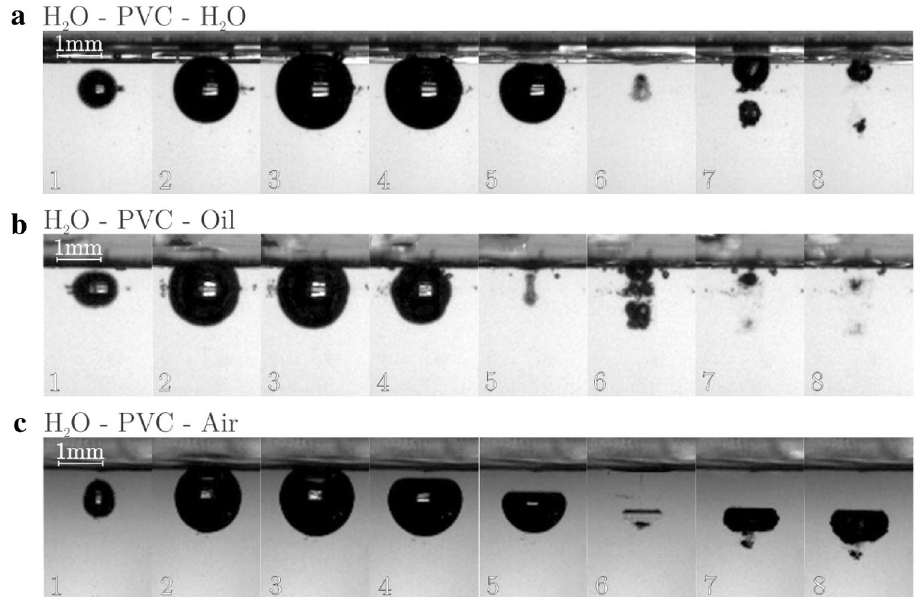
Figure 3. Typical bubble evolution for ( a ) water-PVC-water, ( b ) water-PVC-oil, ( c ) water-PVC-air interface at γ =